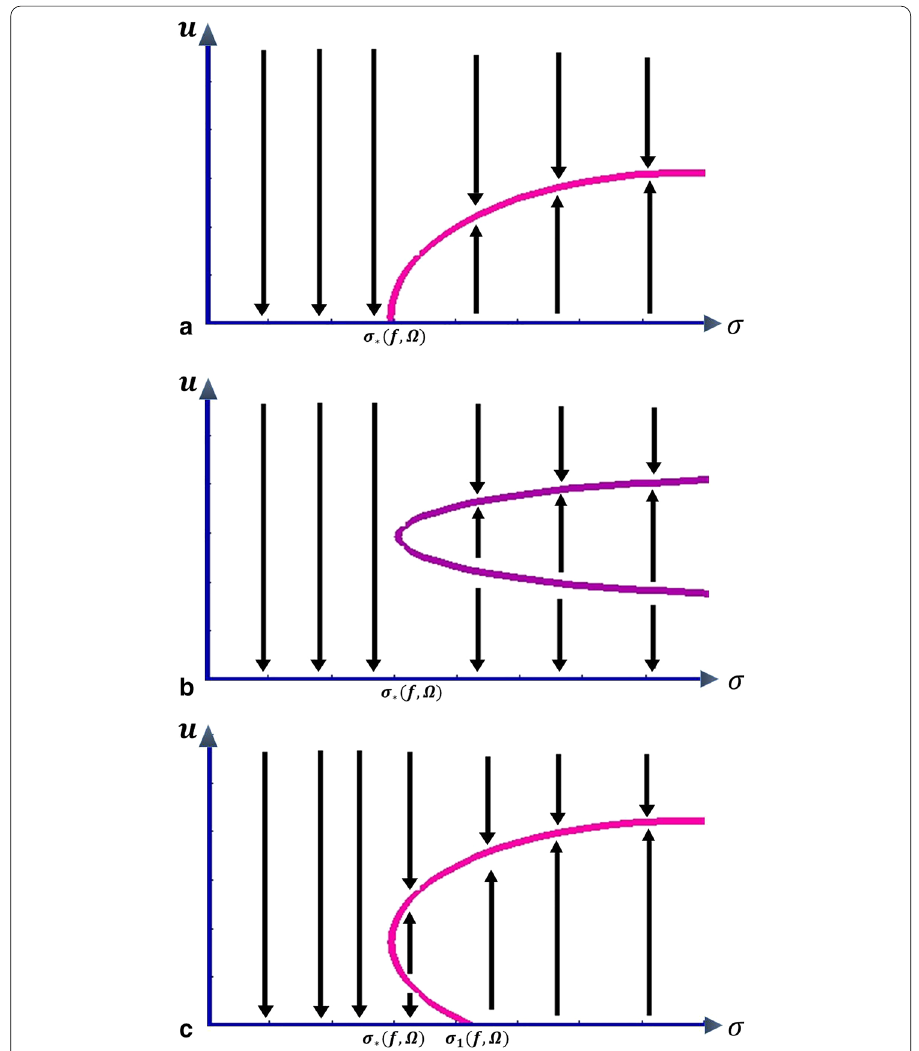
Fig. 4 Classical bifurcation diagram from left to right showing for logistic; strong Allee effect and weak Allee 1 , where d is the diffusion d effect, respectively. Here σ − =